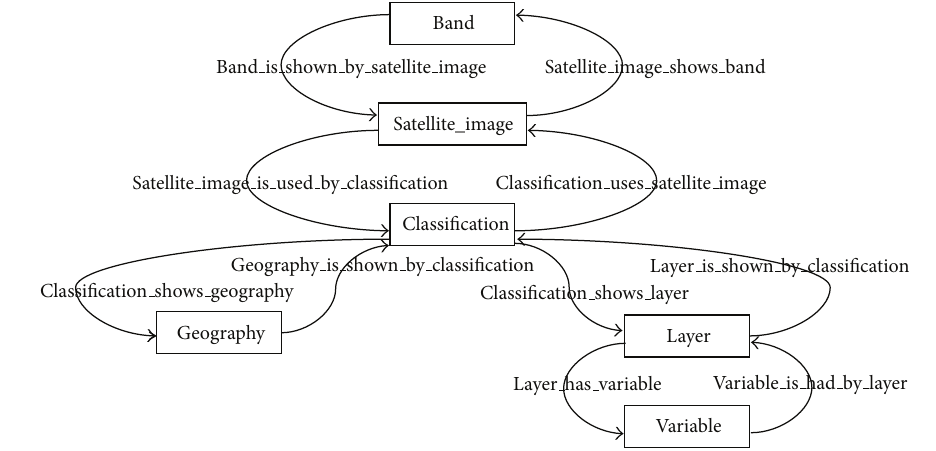
Figure 6: Ontological relationships of a classification. Table 2: Formal EID ontology